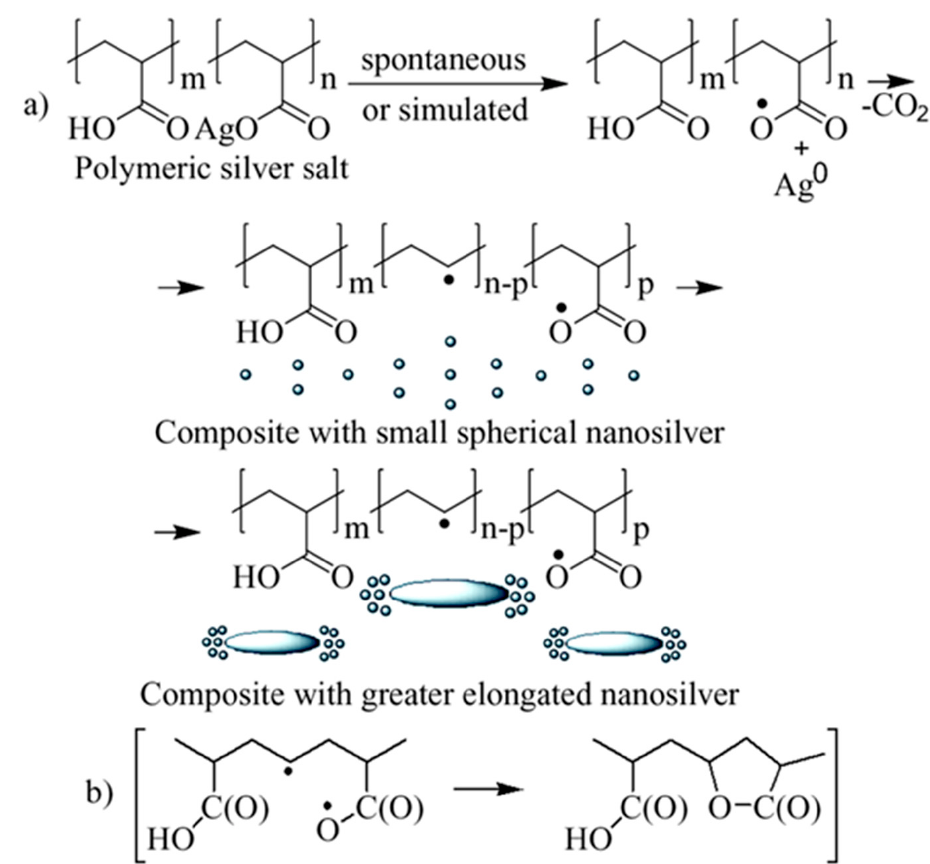
Figure 10. Redox mechanism of ( a ) Ag + cations to Ag 0 atoms conversion and the related polymeric radicals generation, as well as small spherical silver nanoparticles formation and their further evolution into novel and greater elongated nanoparticles; ( b ) formation of γ -butyrolactone cycles due to intramolecular recombination of the neighboring radical centers.